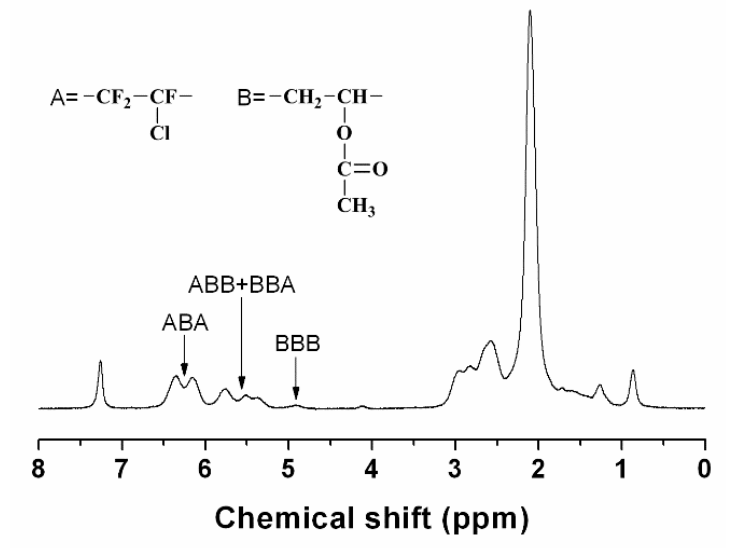
Figure 6. 19 F NMR spectrum of poly(CTFE-co-VAc) (Sample P7) recorded in CDCl 3 at room temperature.